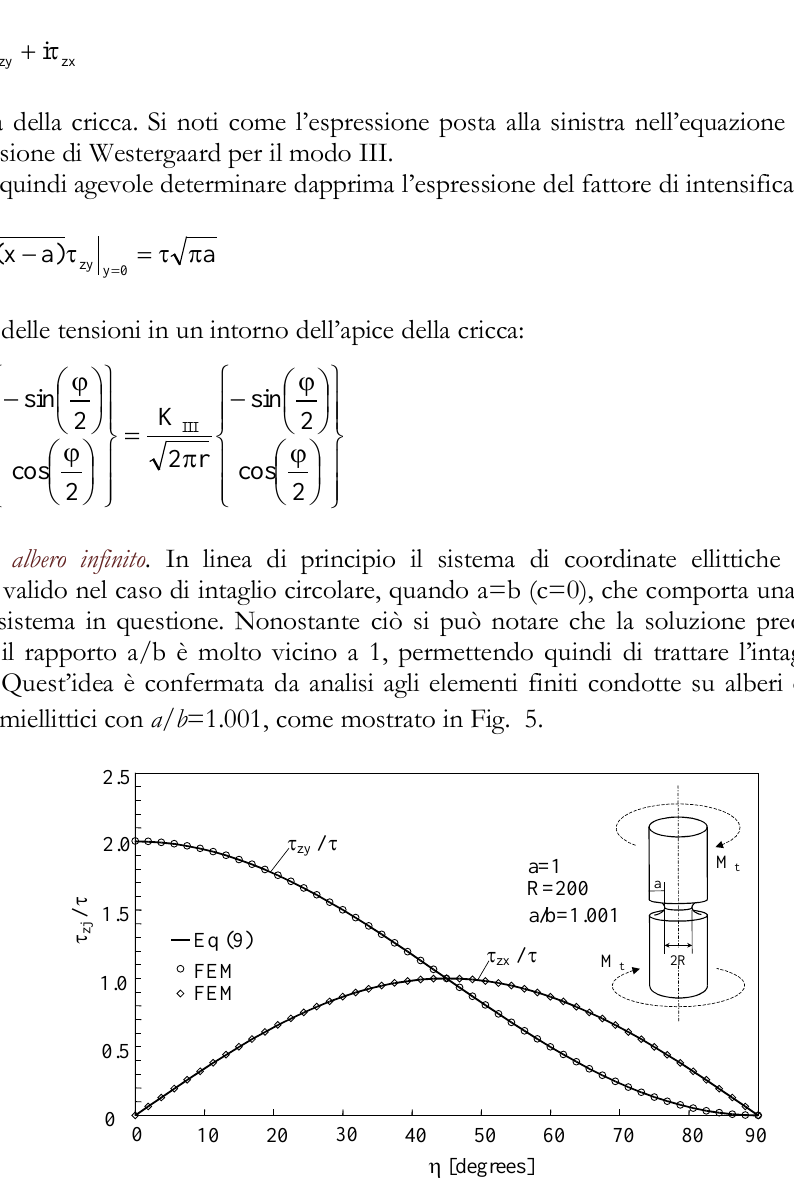
τ sul bordo dell’intaglio nel caso di un intaglio che può essere considerato semicircolare Figura 5: Componenti di tensione τ and zx zy (a/b=1.001). Le tensioni sono normalizzate rispetto alla tensione